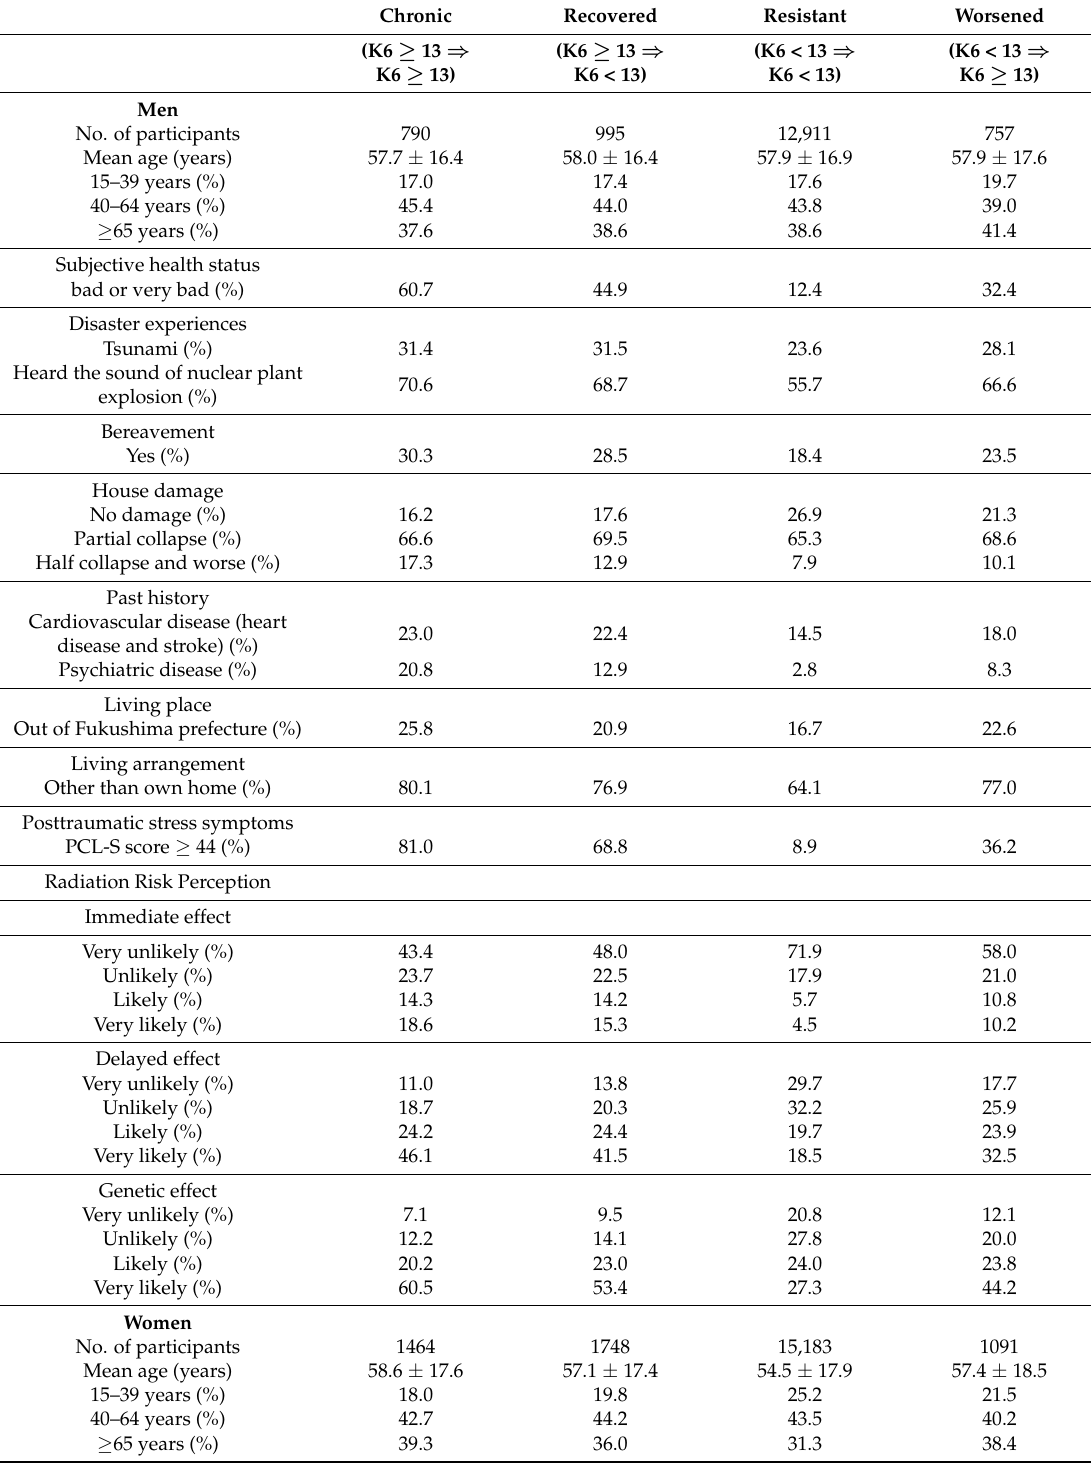
Table 1. Baseline characteristics of each group in